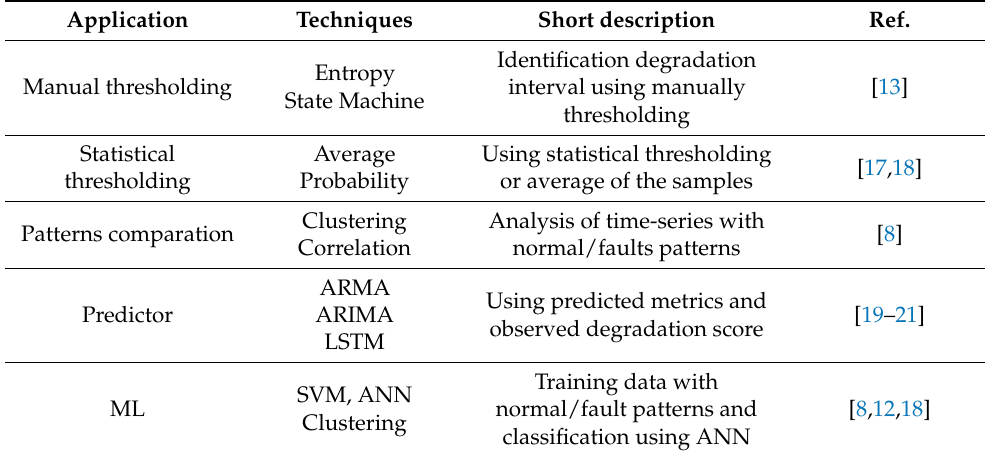
Table 2. A summary of the methods used for fault/anomaly